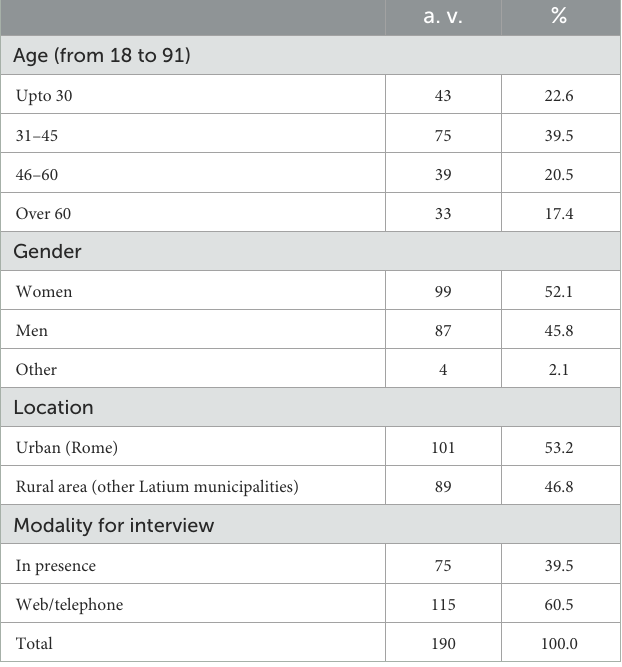
TABLE 2 General characteristics of the sample (absolute values and